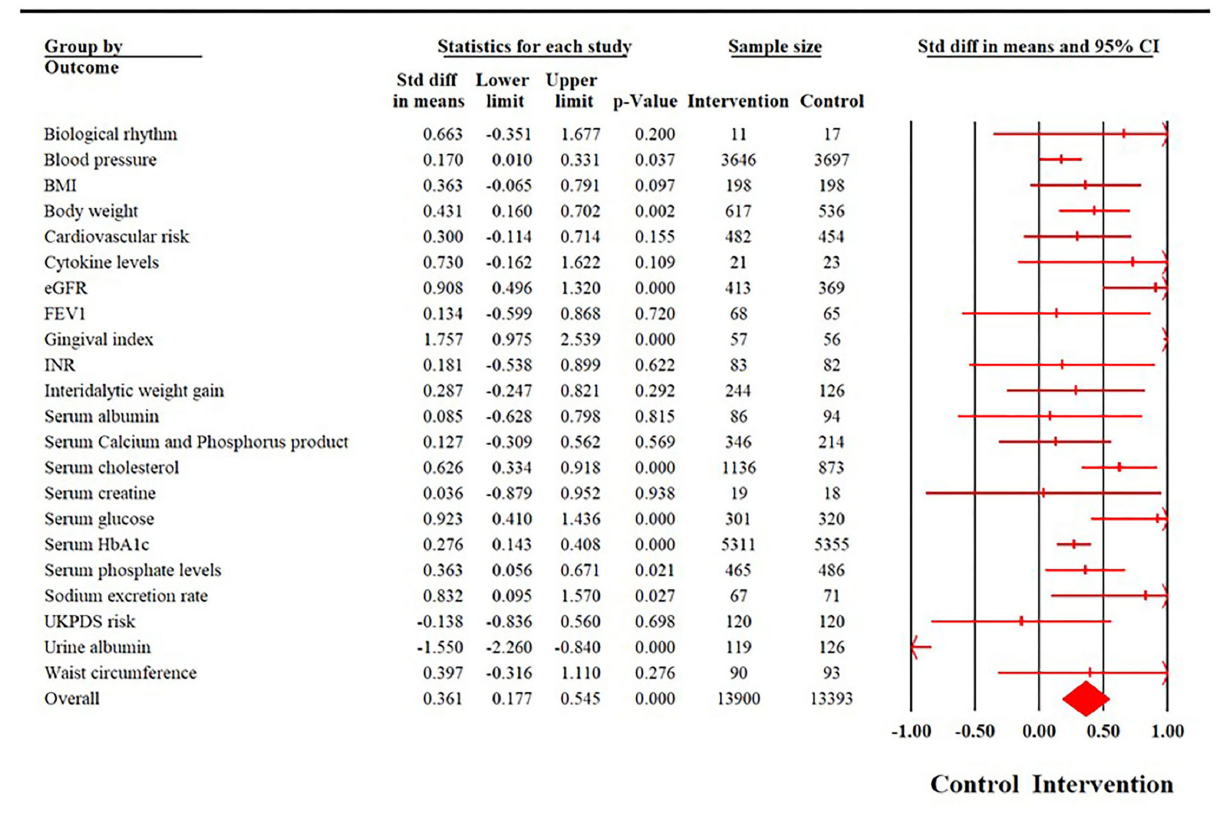
FIGURE5 Summary of a forest plot demonstrating the effectiveness of therapeutic patient education interventions among different biological outcomes.